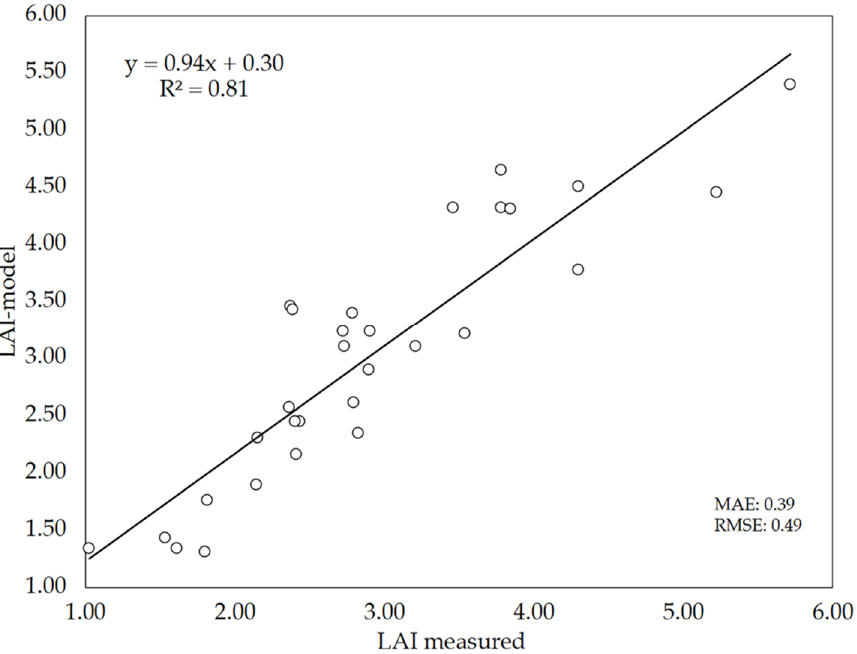
Figure 11. Relationship between LAI estimated by the deep-learning (DL) model (LAI-model) and measured LAI (direct method). Table 4. LAI values determined for ten wheat cultivars with the direct and the two indirect methods assessed in this study during DaS = 58 (2 February